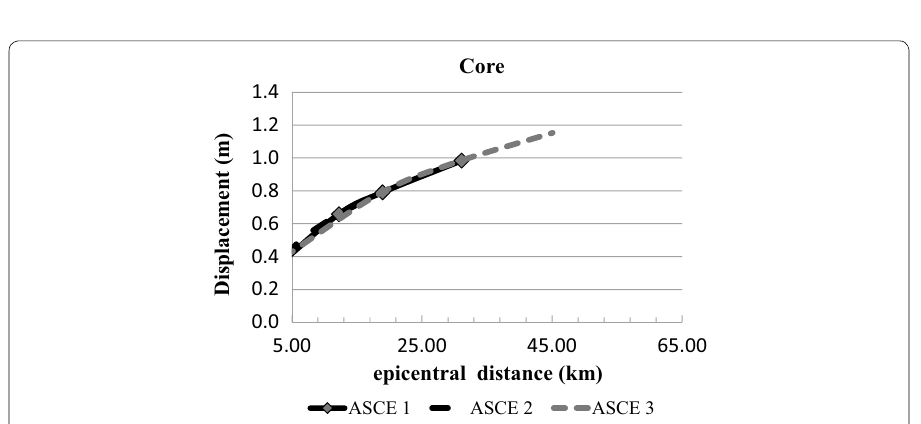
Fig. 7 Displacements in function of Mw